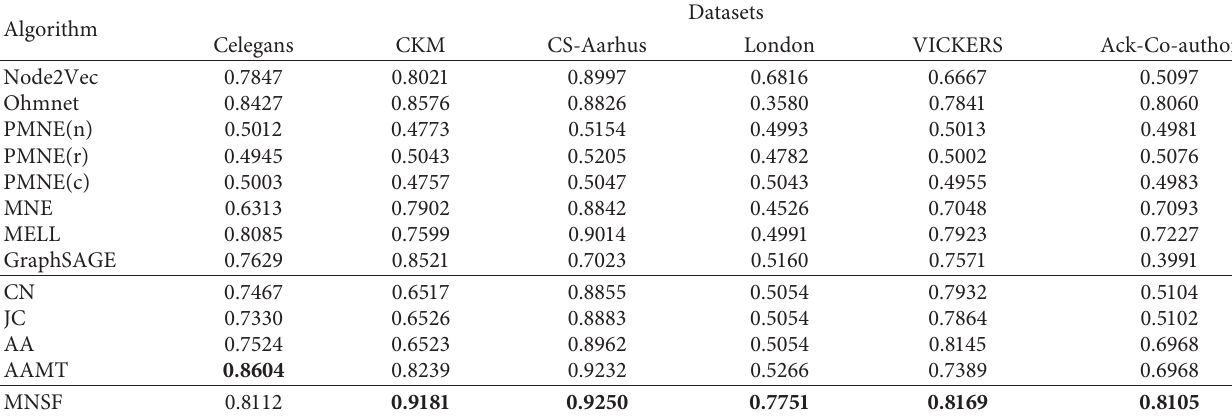
Table 2: Link prediction